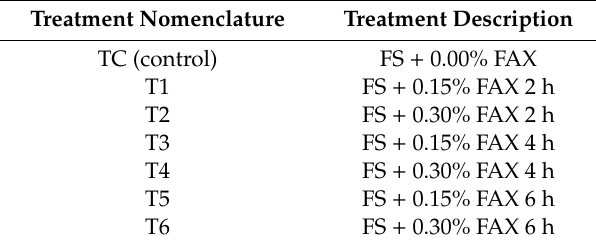
Table 6. Nomenclature and description of frankfurter sausages